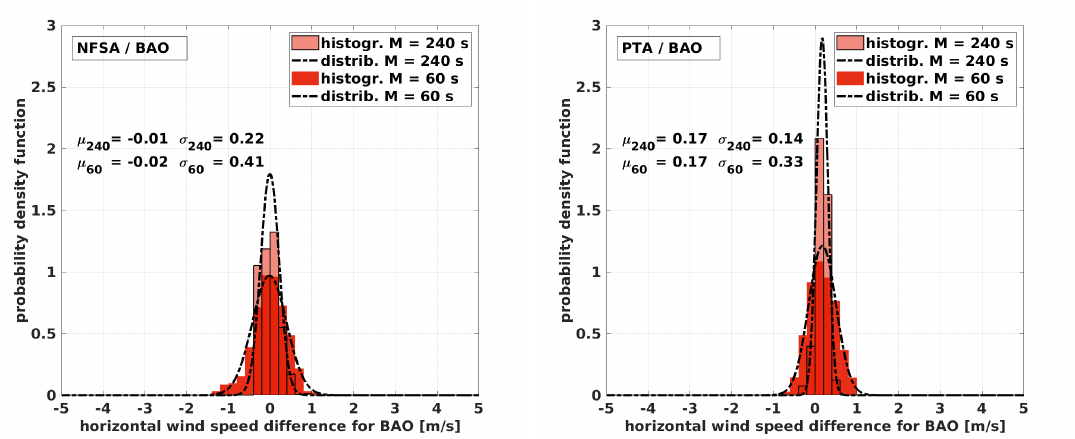
Figure 14. Normalized distribution and probability density function with the fitted normal distribution for the flight at the Boulder Atmospheric Observatory ( BAO ). The plots show the deviation between the MHPA and the NFSA ( left ) and the MHPA and the PTA ( right ) for M = 240 s and for M = 60 s.